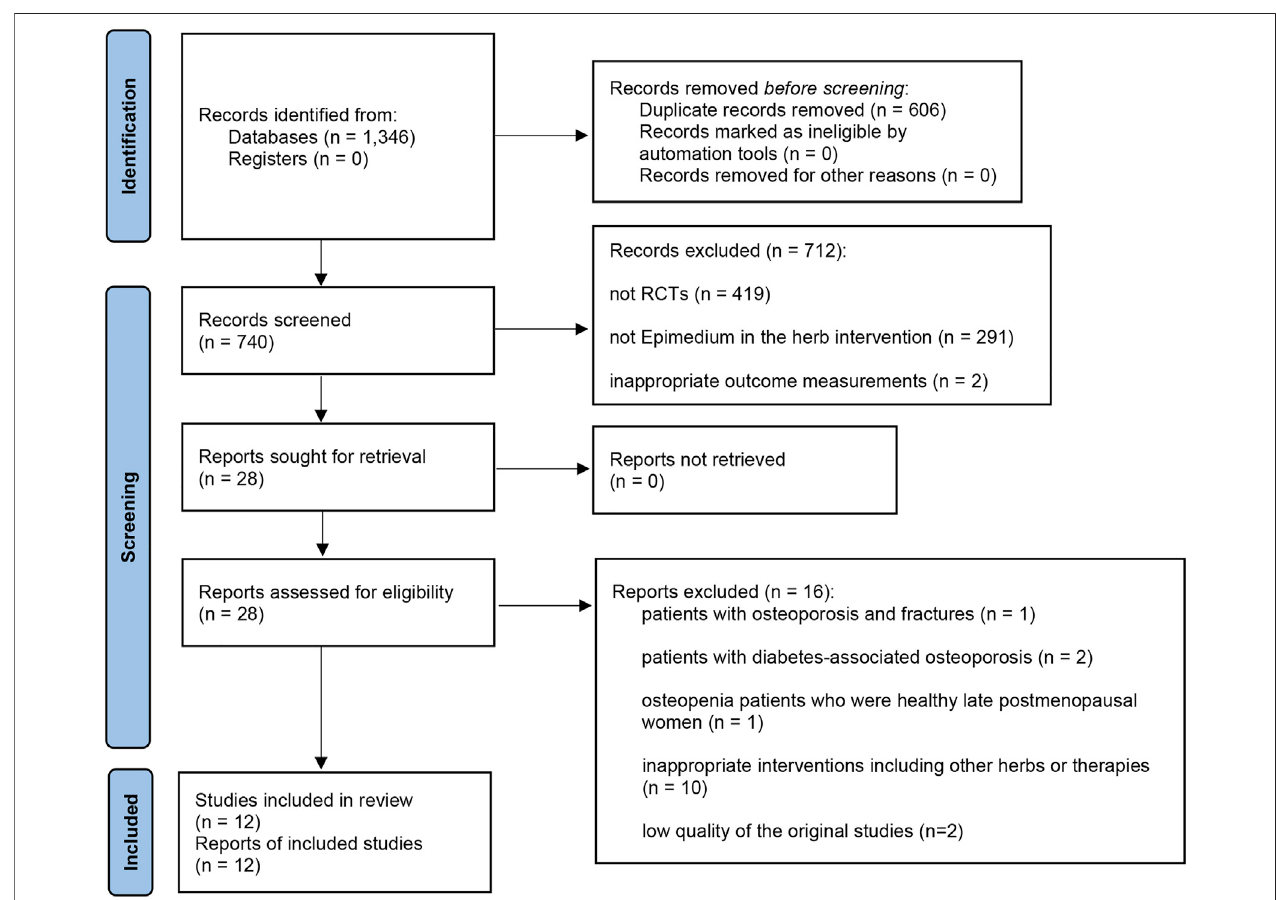
FIGURE 1 | PRISMA2020 fl ow